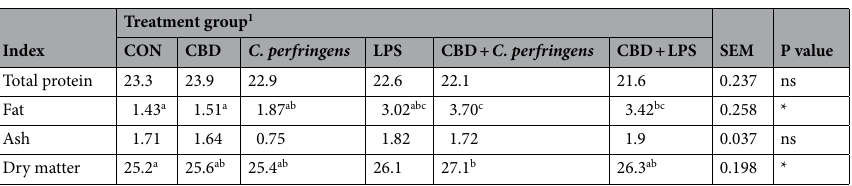
Table 1. Chemical composition of chicken breast muscle (%) in response to treatments. 1 CON: received the basal diet over the entire period of the experiment and no challenge; CBD: received the CON diet supplemented (on top) with 30 g/kg Cannabis sativa extract; C. perfringens and LPS: received the CON diet and subjected to C. perfringens and E. coli LPS challenge, respectively; CBD + C. perfringens and CBD + LPS: received the CBD diet and subjected to C. perfringens and E. coli LPS challenge, respectively. a–c Means within the same line followed by different superscript letters are significantly different (P < 0.05), and ns indicates no significant difference. The data are the mean of 8 replicates, and the variability is described as the standard error of the mean (SEM).